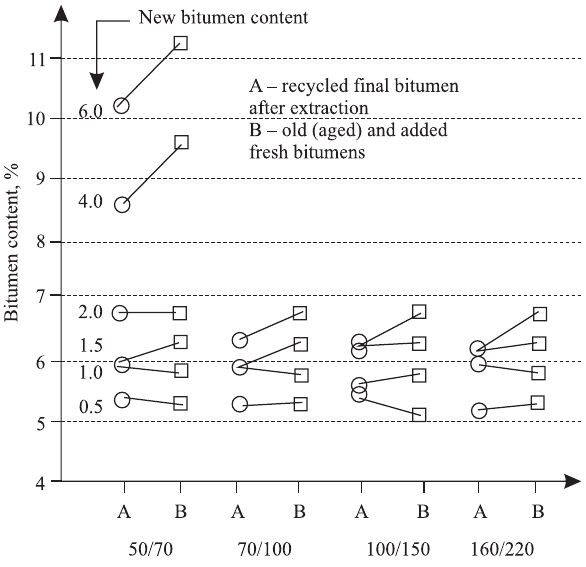
Fig. 8. Recycled bitumen amount in RAP, obtained by extraction (A) and arithmetically adding the values of aged and virgin bitumen